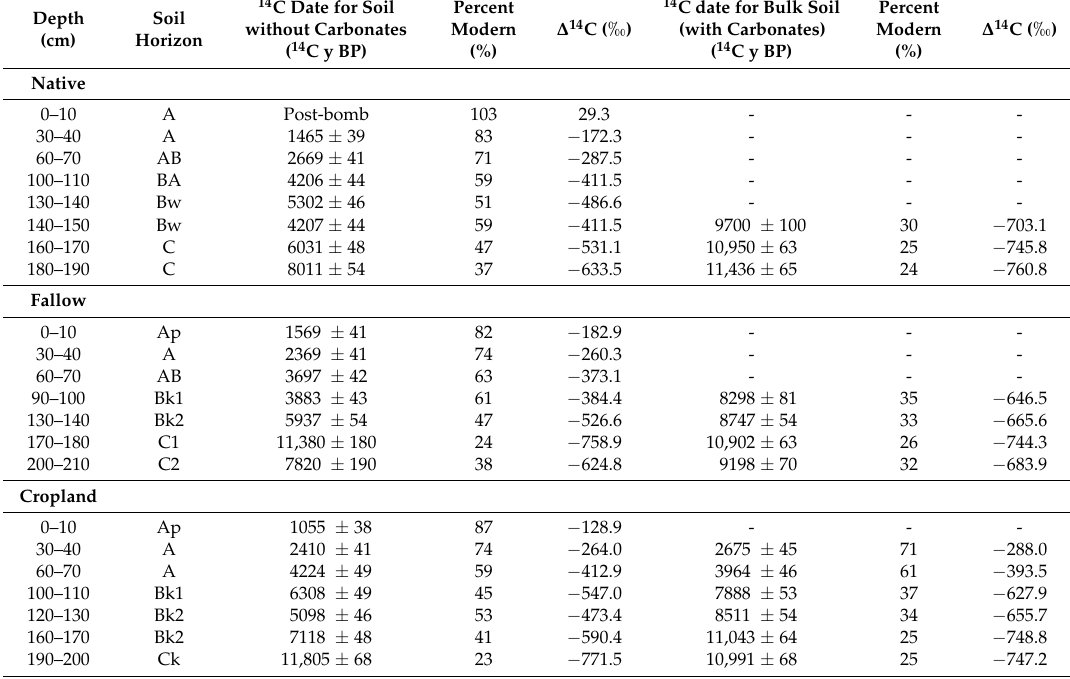
Table 6. Soil 14 C date with depth and site for the representative soil profile (sampling date: 1997; year of 14 C measurements: